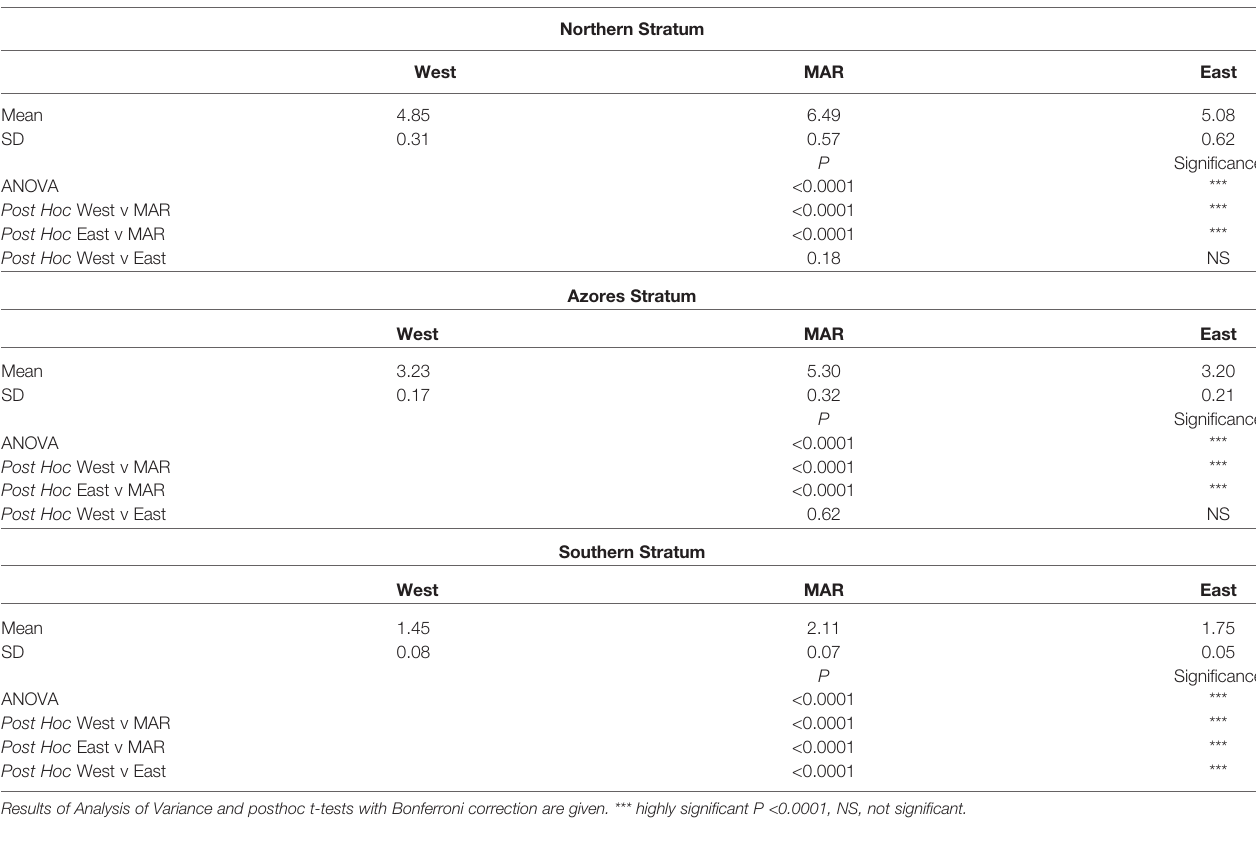
TABLE 2 | Comparison of particulate organic carbon fl ux (POC Flux) mgC.m -2 .day -1 over the Mid- Atlantic Ridge (MAR) and adjacent abyssal regions West and East during 2002-2020 for the three latitudinal strata shown in Figure 2 .